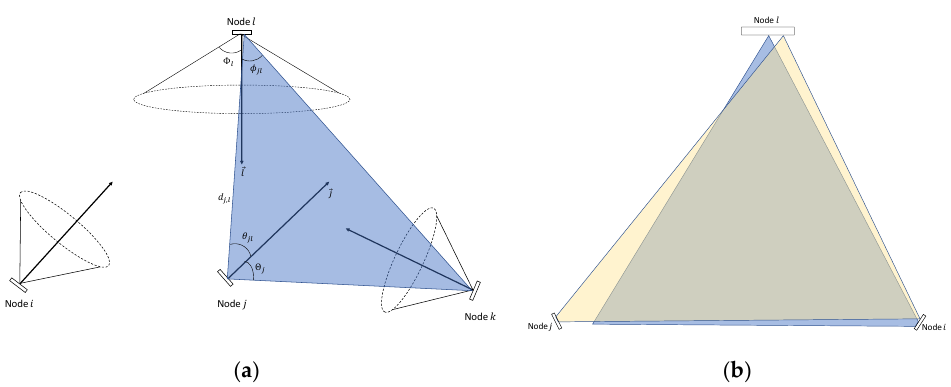
Figure 2. Conceptual diagram for the ( a ) exposed and ( b ) hidden node collision.